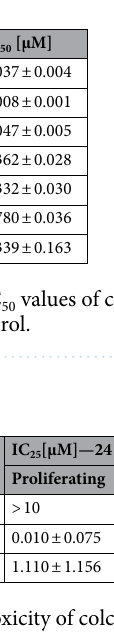
Table 2. Cytotoxicity of colchicine and the compounds 2 and 6 against SKOV-3 human cancer cell line 24 h; 1 —positive control. Data for proliferating cells after 72 h are given in Table 1.